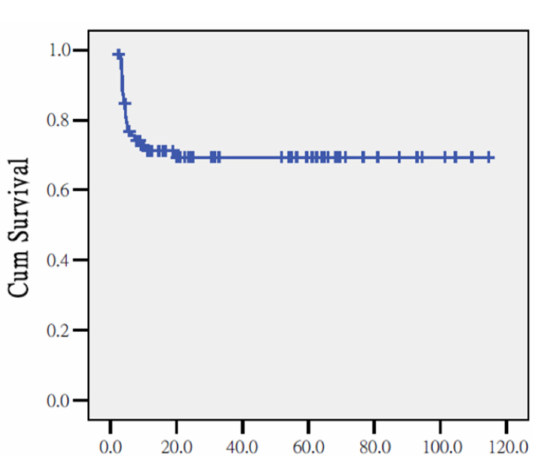
Figure A1. Nodal relapse-free survival. Months after radiotherapy. Median duration of neck LN relapse: 3.9 months (range, 2.3 to 19.0).